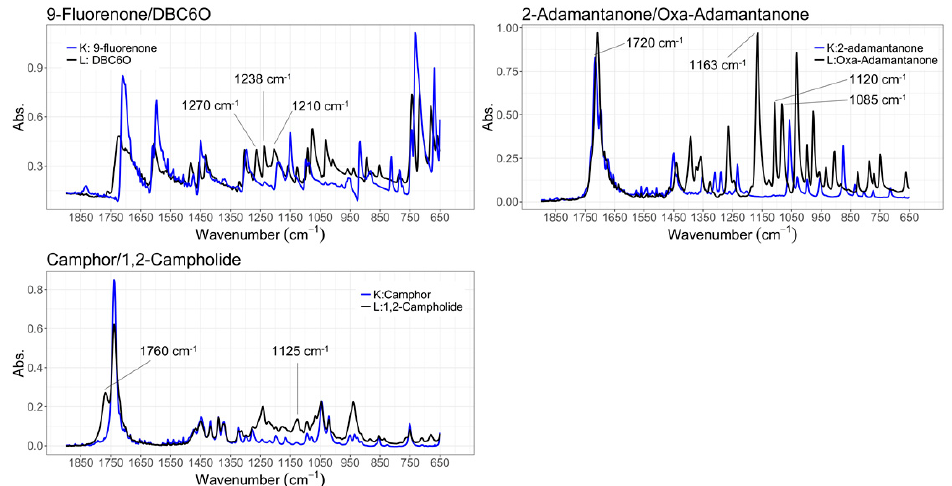
Figure 1. ATR-IR spectra of all lactones produced (in black, preceded by “L” in the legend) compared to the corresponding precursor cyclic ketones (in blue, preceded by “K” in the legend). The presence of the newly formed lactone bond was confirmed by the appearance of several peaks in the 1050–1270 cm − 1 region from the C-O-C and C-O stretching in the ester bond. Additionally, a new band at 1760 cm − 1 from the stretching of O-C=O in 1,2-campholide was